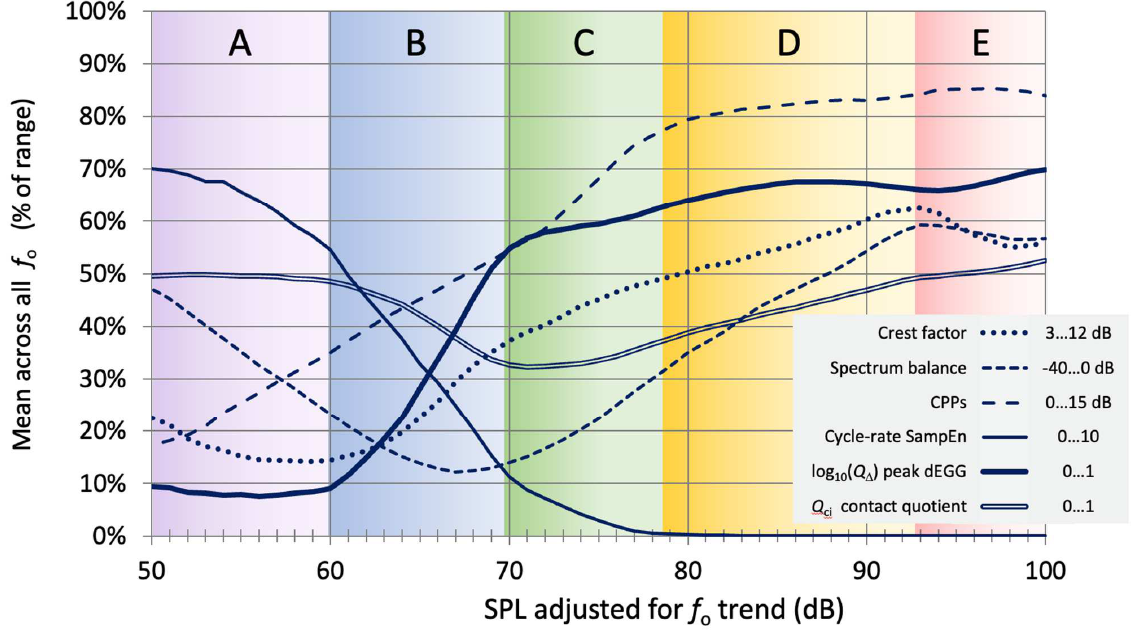
Figure 3. Variation of six metrics over the SPL range shown in Figure 2. The broken lines refer to acoustic metrics and the solid lines to EGG metrics. The adjusted SPL axis can be visually divided into five subranges based on the metric values. Range A: soft phonation without vocal fold contact; B: transition zone where vocal fold contact sets in; C: ‘loose’ phonation but not entirely stable; D: ‘firm’ phonation with high stability; E: ‘hard’ phonation, approaching saturation in most metrics.